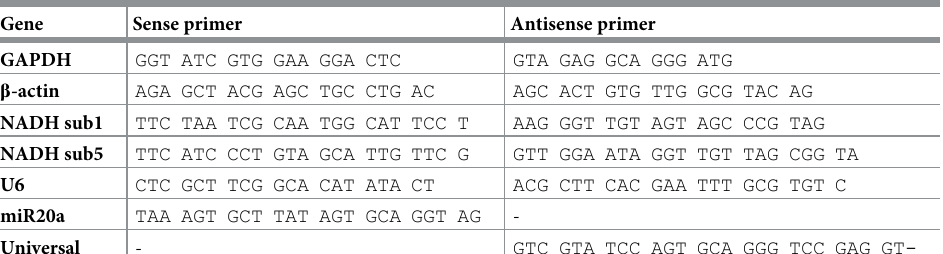
Table 1. List of primers used for